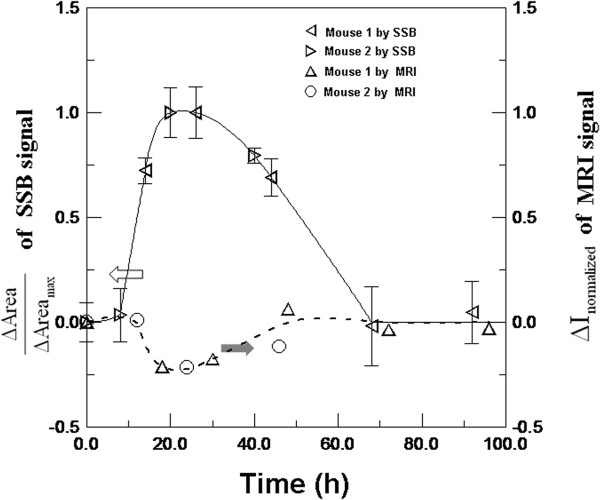
Comparison between ΔArea/Areamax by SSB and Inormalized by MRI for mouse 1 and mouse 2.